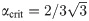
Main components of the model for a single translation inhibitor and exemplary dose-response curves.(A) Schematic of processes captured by the model. Ribosomes (double ovals) are synthesized with the rate s(λ) and are initially unbound by antibiotic (ru). Unbound ribosomes contribute to growth. Antibiotics enter the cell (aex → a) and bind to and detach from ribosomes with second-order and first-order rate constants kon and koff, respectively. Bound ribosomes (rb) do not contribute to growth [10]. (B) Bacterial growth laws. When the growth rate is varied by changing the quality of the nutrient environment, the ribosome concentration increases linearly with growth rate (solid line). If growth is inhibited by a translation inhibitor, the ribosome concentration increases with decreasing growth rate (dashed lines). The intercepts of the solid and dashed lines determine the minimal (rmin) and maximal ribosome concentration (rmax), respectively, which are Δr apart [9, 10]. (C) Examples of dose-response curves. The model can produce both (i) steep and (ii) shallow dose-response curves, depending on the parameter α (see text). The steep dose-response curve has a region of concentrations (gray shaded area) where one unstable (dashed line) and two stable (solid lines) solutions exist. (D) Exact phase diagram for dose-response curves. The shaded area shows the region of drug concentrations where two stable solutions exist. Gray arrows show α for the examples from (C); black arrow shows the critical value αcrit=2/33 above which no bistability can occur.